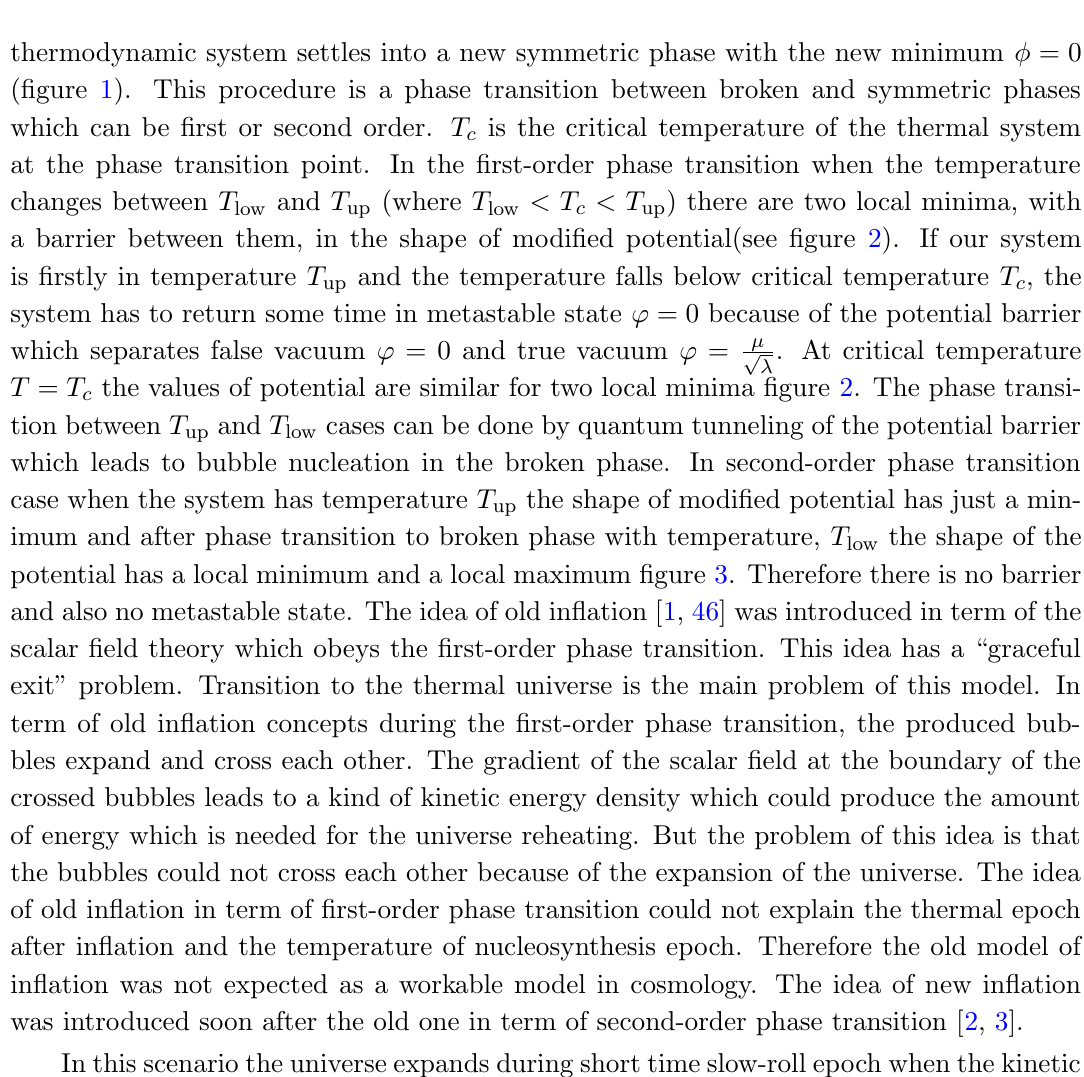
Figure 1 . The phase transition happens between symmetric case (red graph) and symmetry broken case (blue graph) during early time evolution of the